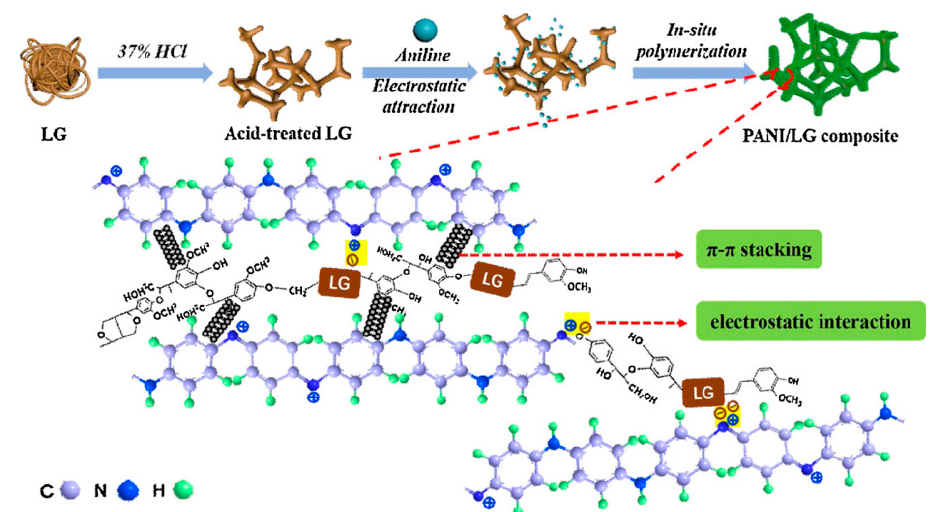
Figure 9. Schematic representation of the mechanism of formation of the PANI/lignin composite and the possible interactions among its components. Reprinted with permission from ref. [53]. Copyright 2019 Elsevier.